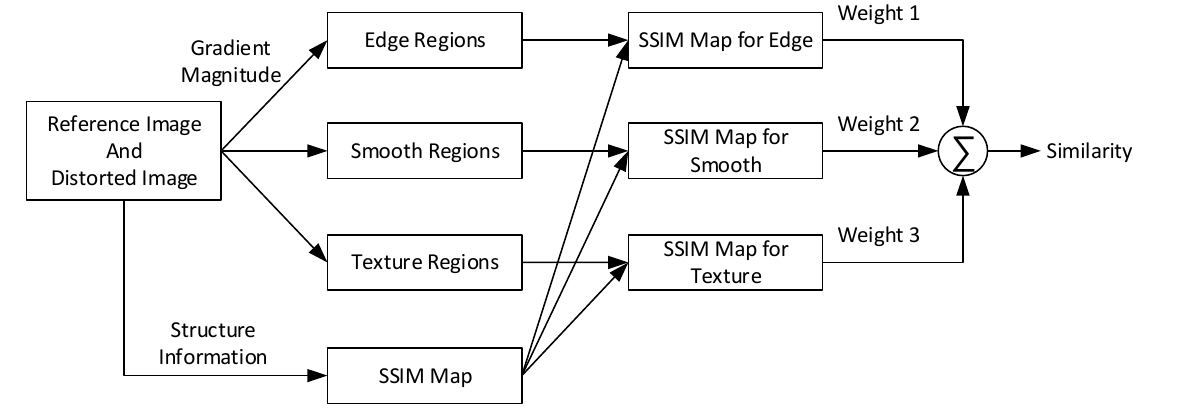
Figure 6. 3-SSIM procedures to quantify the image quality (adapted from [19]).